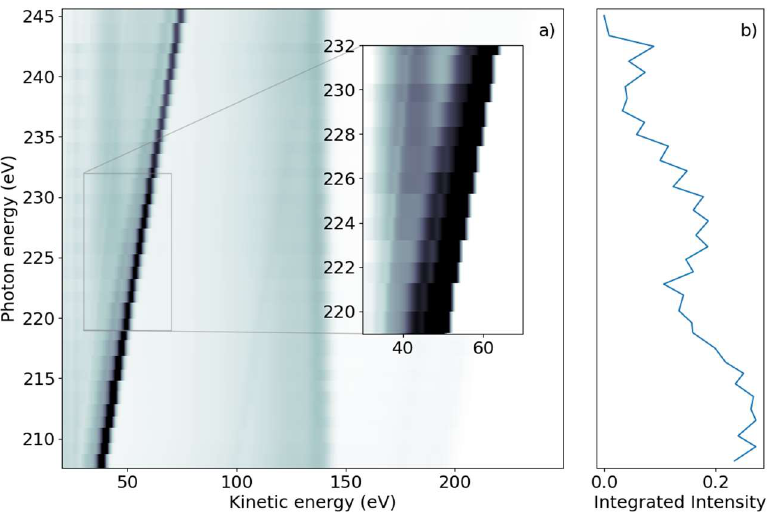
Figure 2. ( a ) Photon energy vs. kinetic energy for the 2-tUra sulfur 2s edge, with the photon energy varying from 208 eV to 245 eV. The bright diagonal feature is the dispersing 2p photoelectron line. A satellite photoelectron line is visible to the left of the main feature. Non-resonant 2p Auger–Meitner electron emission can be seen in the 100 eV to 150 eV range. Coster–Kronig electrons from the 2p -> 2s decay are visible at 40 eV for photon energies above 220 eV. The dispersing dip overlapping the Coster–Kronig feature visible in the inset is an artifact of the readout electronics. ( b ) NEXAFS spectrum obtained by integrating the emission intensity over the whole kinetic energy range.